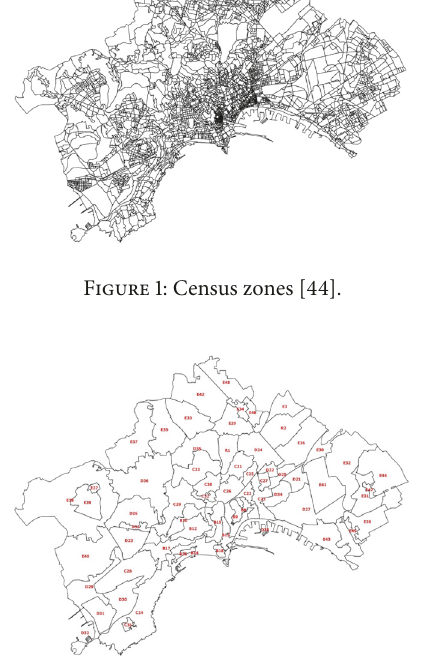
Figure 2: OMI zones [45].